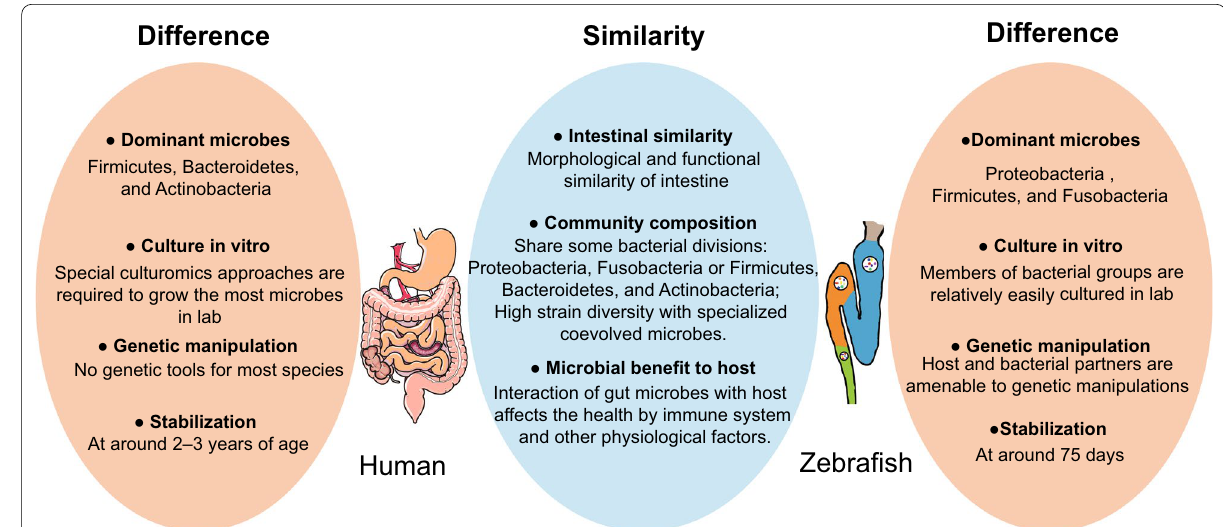
Fig. 3 Physiological function comparison of gut microbiota between zebrafish and